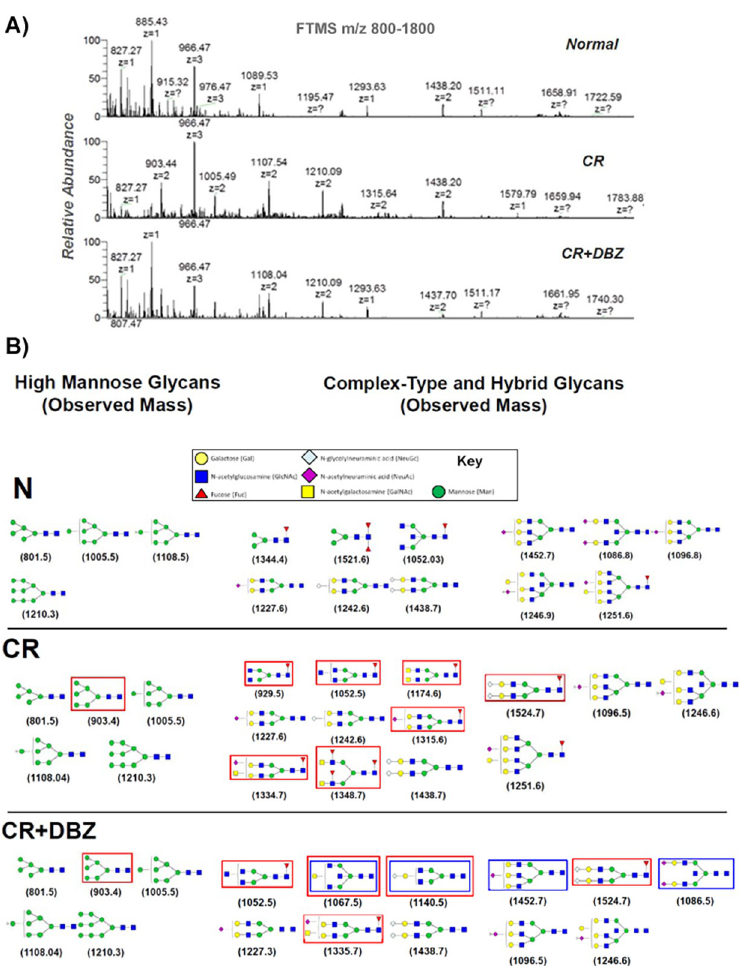
Fig 1. Analysis of colon mucus samples for N -type glycosylation. A. FTMS m/z 800–1800 of mucus samples . Processing of mucus samples from uninfected (Normal), CR-infected (CR) and CR+DBZ-treated (CR+DBZ) mouse colons included removal of lipids and precipitation of proteins into a protein-rich powder that was subsequently treated with trypsin, purified, then treated with PNGase F, to remove N -linked glycans. A full FTMS spectrum was collected at 30,000 resolution with 3 microscans. The highest abundance glycans are primarily high mannose, and complex-type species containing N -glycolylneuraminic acid (NeuGc). MS/MS analysis of the highest abundance complex-type glycans appears as a z = 3 ion at m/z 966. B. Detection of glycans from each sample, as well as the results of each MS/MS analysis from total ion mapping (TIM) analysis. Some representative mucus glycan structures are shown together with the terminal end structures including the interconnecting linkages of the different monosaccharides, which are explained in the key. Red rectangles represent differences between uninfected (N) and CR-infected (CR) mucus samples while blue rectangles represent mucus glycans unique to CR+DBZ-treated mice.